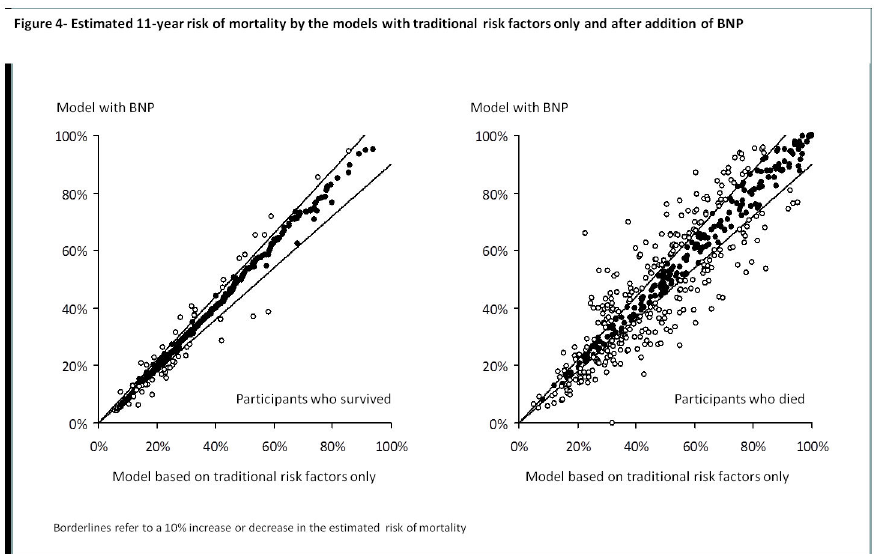
Figure 4. Estimated 11-year risk of mortality by the models with traditional risk factors only and after addition of BNP.